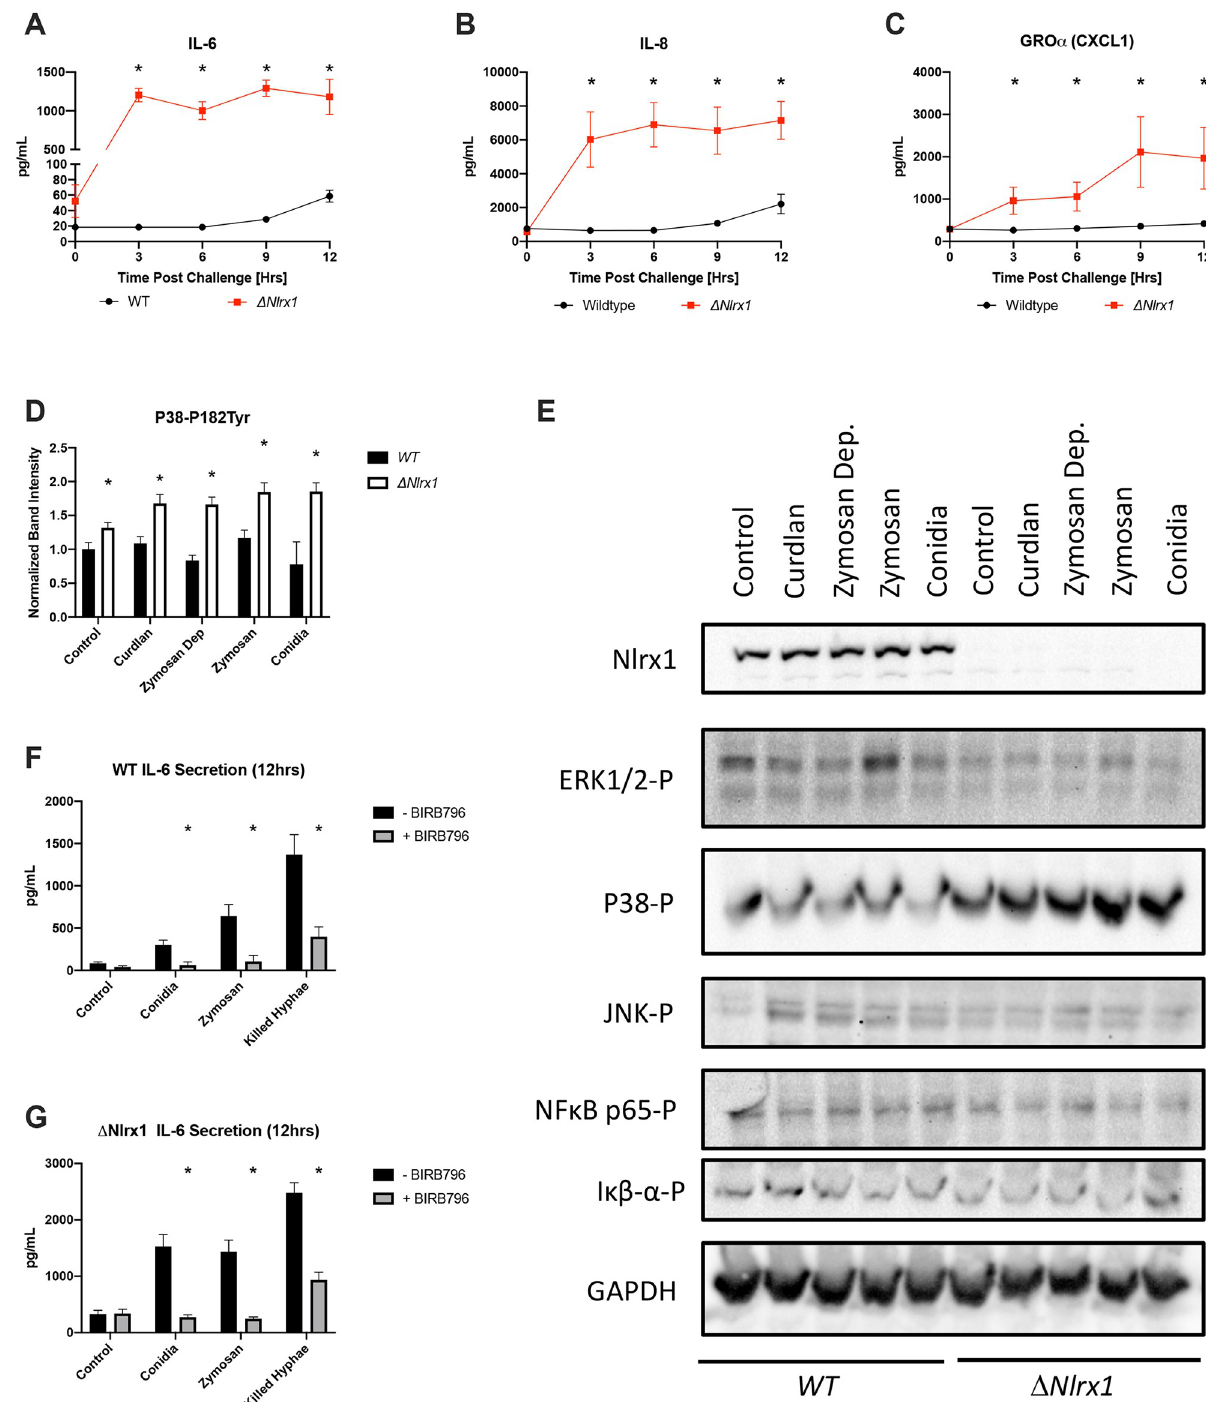
Fig 9. Temporal immune responses by BEAS-2B cells during in vitro fungal challenge assays. Freshly harvested AF293 conidia (5 X 10 5 ) were challenged against wild type and Δ Nlrx1 BEAS-2B airway epithelial cells (5 X 10 5 ) at 37˚C at 5% CO 2 . Total supernatant was harvested immediately prior to challenge (0 hrs), and at 3, 6, 9, 12 hrs post challenge. Concentration of cytokines (IL-1 β , IFN- α , IFN- γ , TNF- α , MCP-1, IL-6, IL-8, IL-10, IL- 12p70, IL-17A, IL-18, IL-23, and IL-33) and chemokines (MCP-1 (CCL2), RANTES (CCL5), IP-10 (CXCL10), Eotaxin (CCL11), TARC (CCL17), MIP- 1 α (CCL3), MIP-1 β (CCL4), MIG (CXCL9), MIP-3 α (CCL20), ENA-78 (CXCL5), GRO α (CXCL1), I-TAC (CXCL11)) in culture media was determined by flow cytometry bead based array. (A-C) Differentially secreted cytokines and chemokines are presented. (DE) Western blot analysis and quantification of phosphorylated (-P) ERK1/2-P, P38-P, JNK-P, NF κ B p65-P, I κβ - α -P, Nlrx1, and GAPDH three hours post treatment with fungal